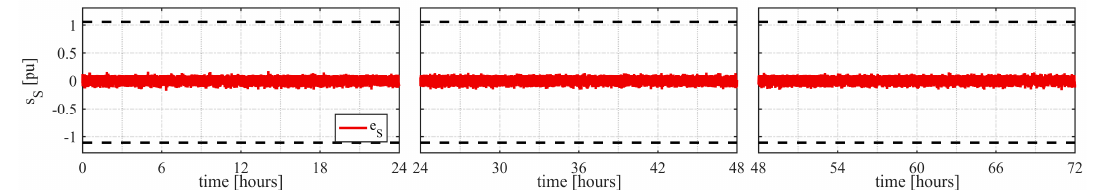
Figure 10. The S power profiles achieved by OPEM over three days.